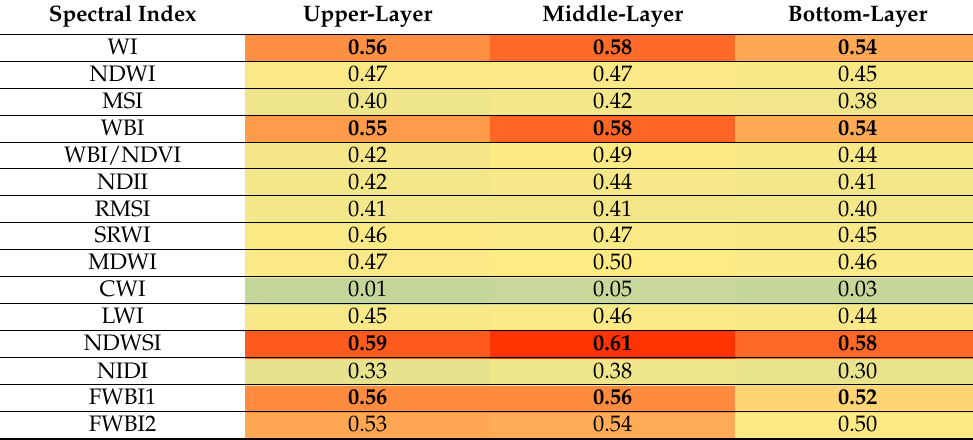
Table 4. The R 2 between published spectral indices derived from spectral reflectance of the entire canopy and the LWC for the three vertical layers by using datasets from Exp. 1 and 2. Colors correspond to the level of performances of spectral indices, from light blue for minimum R 2 value to red for maximum R 2 value. Upper-Layer Middle-Layer